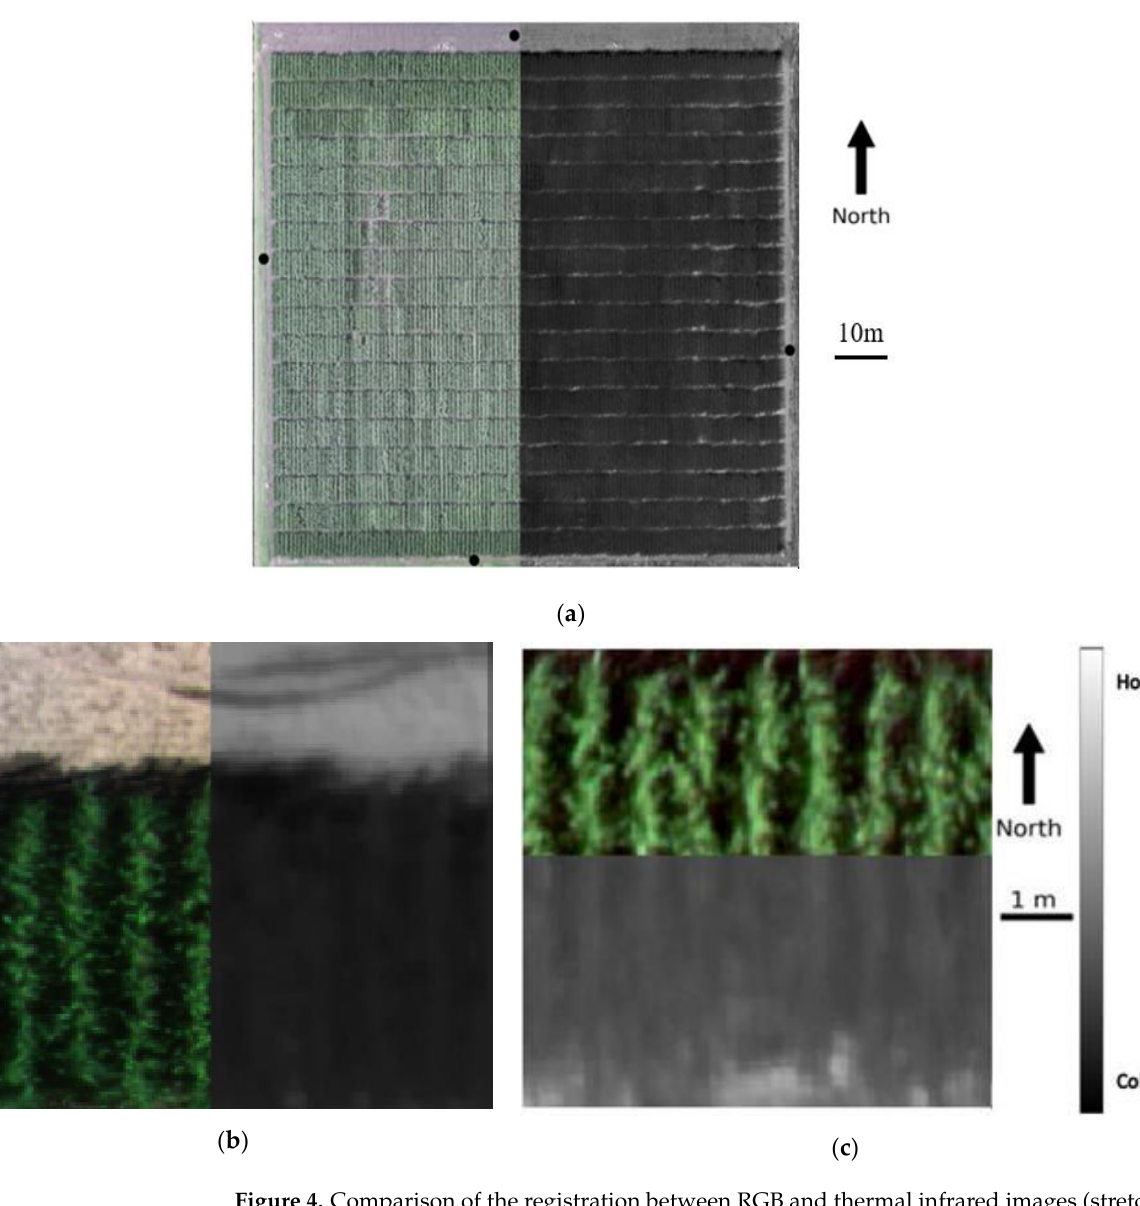
Figure 4. Comparison of the registration between RGB and thermal infrared images (stretched for better visualization) taken on 28 July 2020. Both images were collected at the same time from the same camera during flight, but have slightly different fields of view and resolutions, so co-registration is required to remove any offsets. ( a ) field level registration where black dots indicate the GCPs used for registration accuracy evaluation; ( b ) plot level registration (vertical registration); ( c ) plot level registration (horizontal registration).